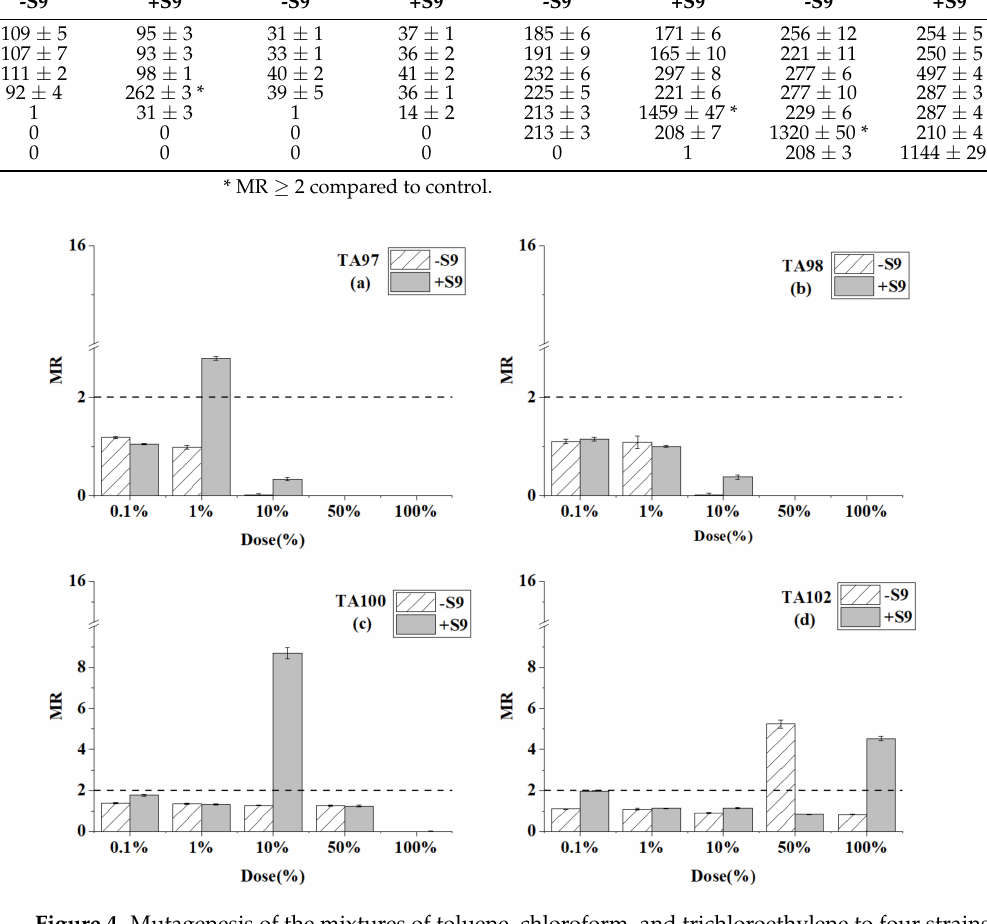
Figure 4. Mutagenesis of the mixtures of toluene, chloroform, and trichloroethylene to four strains in the presence and absence of S9 liver extract; ( a ) TA97 strain; ( b ) TA98 strain; ( c ) TA100 strain; ( d ) TA102 strain. The mutagenicity ratio (MR) is the average ratio ( ± SE) from three parallel experiments. For the TA97 strain and TA98 strain without S9 (Table 4 and Figure 4), no mutagenicity was detected at any ratio. Moreover, when the ratios were greater than 10%, no colony growth was observed. The only difference is that the mixture caused mutagenicity to TA97 strain at 1% ratio with S9. For the TA100 strain, the positive result was only detected at 10% with the addition of S9. The mixture showed an inhibiting effect on the TA100 strain at the highest ratio. For the TA102 strain, mutagenicity was only detected at 50% without S9, and at 100% ratio by adding